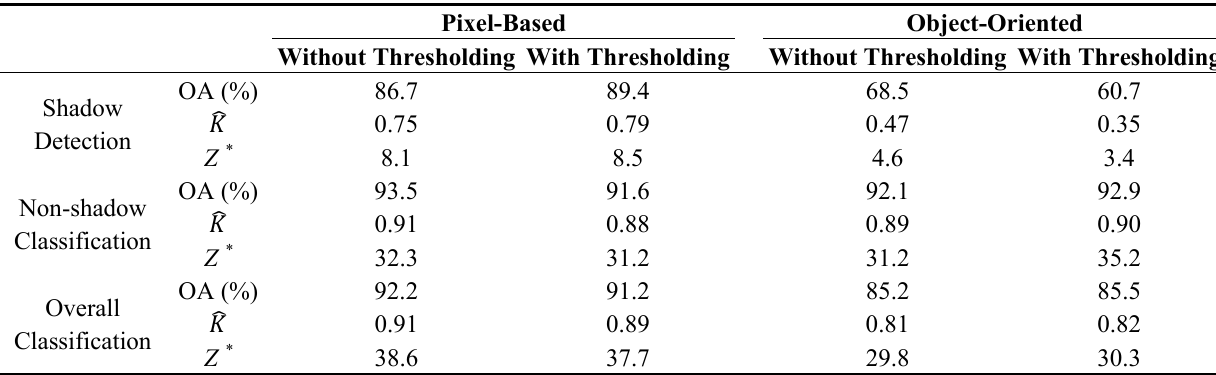
Table 3. Summary of the accuracy of shadow detection and image classification with the pixel-based and object-oriented methods a